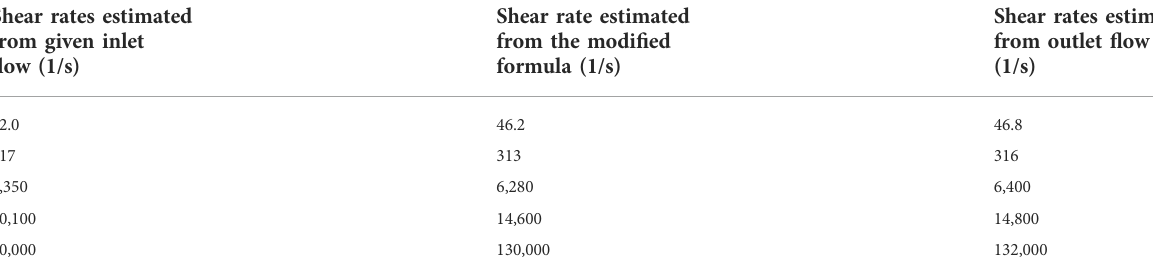
TABLE 1 Comparison of the shear rates estimated in different methods. Shear rates estimated from given inlet